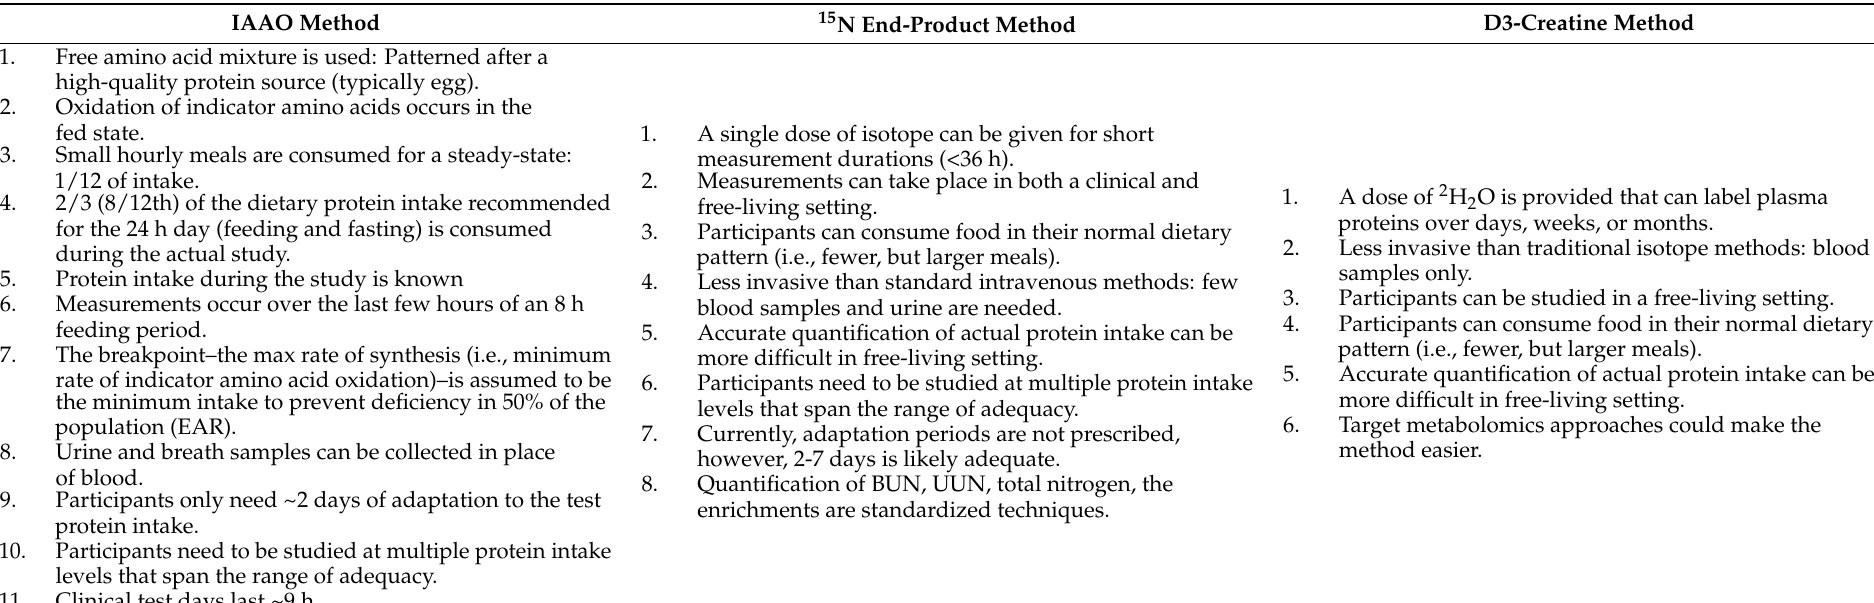
Table 3. Considerations for each of the current methods to quantify protein kinetics in